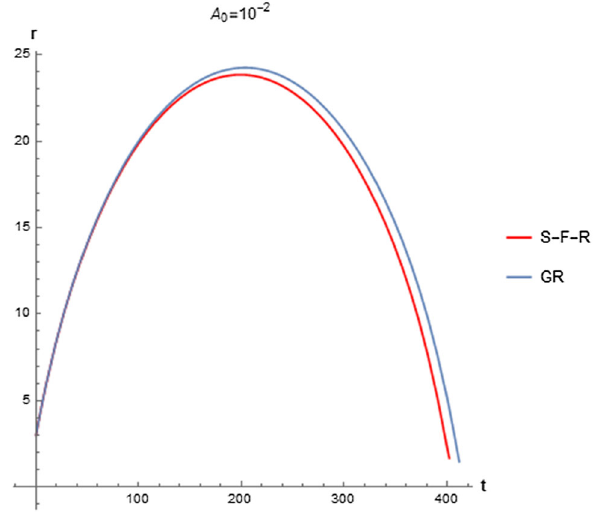
Fig. 1 This is an r , t graph of the timelike paths that we find using our theoretical SFR (red curve) model in comparison to the geodesics of GR (blue line) for E = 0 . 98, L = 1, r 0 = 3 and ( a , b , c ) = ( 1 , 1 , 1 )